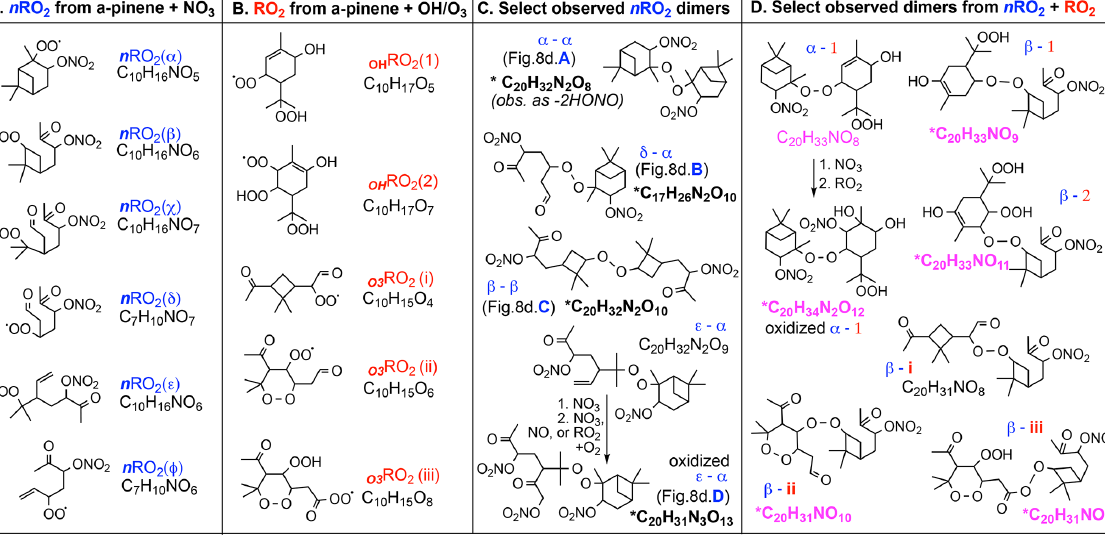
Figure 10. Structures and molecular formulas for (a) n RO 2 from NO 3 -initiated chemistry (Fig. 9), (b) RO 2 from OH or O 3 chemistry (Xu et al., 2019; Iyer et al., 2021), (c) prominent dimers observed from n RO 2 self- or cross-reactions, and (d) dimers from synergistic n RO 2 + RO 2 couplings observed in the simulated nighttime reactions. Dimers with chemical formulas written in pink are uniquely observed in the simulated nighttime experiments; those marked with an asterisk have moderate to high signal (40 >